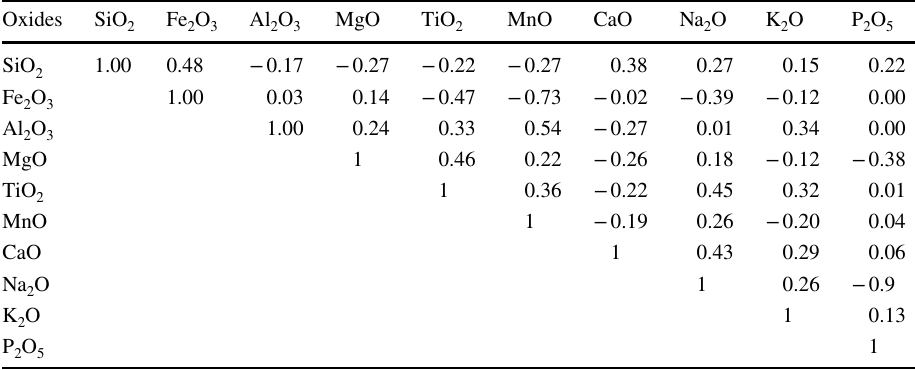
Table 2 The correlation coefficient for the major